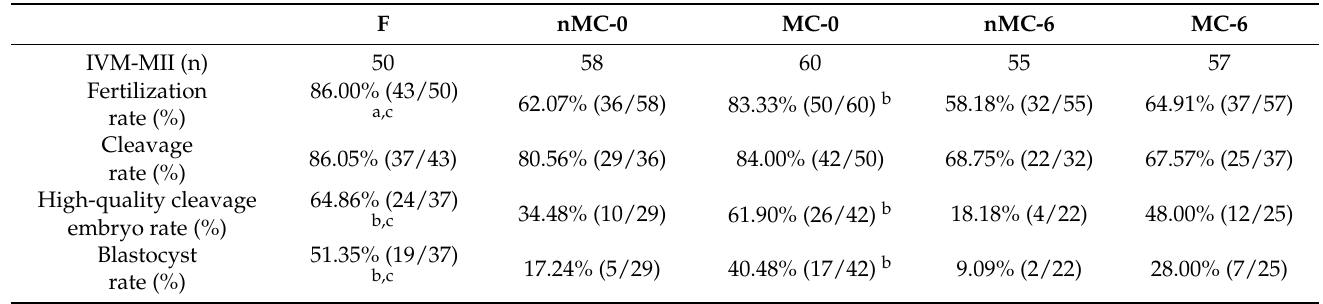
Table 1. Effect of 10 -9 M MT treatment on the developmental competence of cryopreserved hu- man